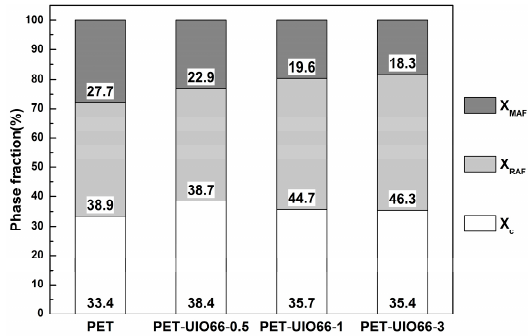
Figure 11. Different phase fractions of PET and the PET/UIO-66 nanocomposites.